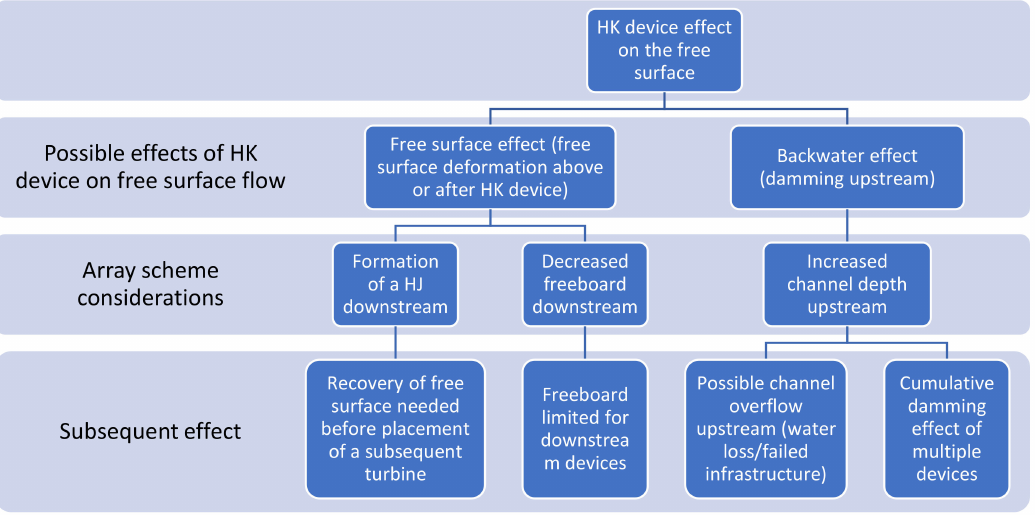
Figure 5. Water surface deformation from HK devices in inland flow